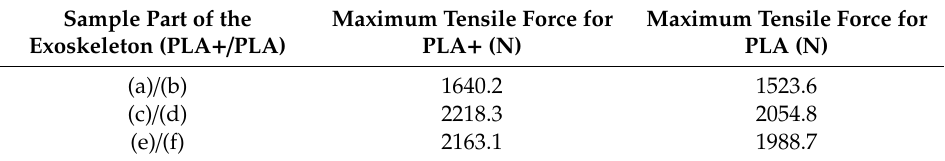
Table 4. Maximum tensile force for selected exoskeleton